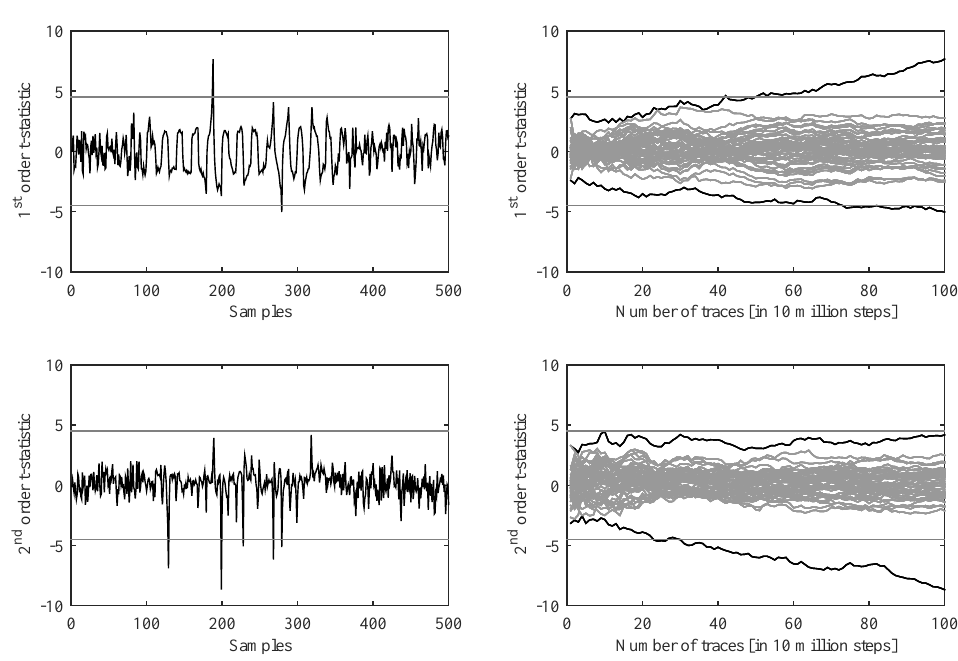
Figure 6: Univariate fixed-vs.-random t-test results for AES-128 using 1 billion traces. The left two plots show the results for the first two statistical order moments. The right two plots show the t-statistics as a function of the number of